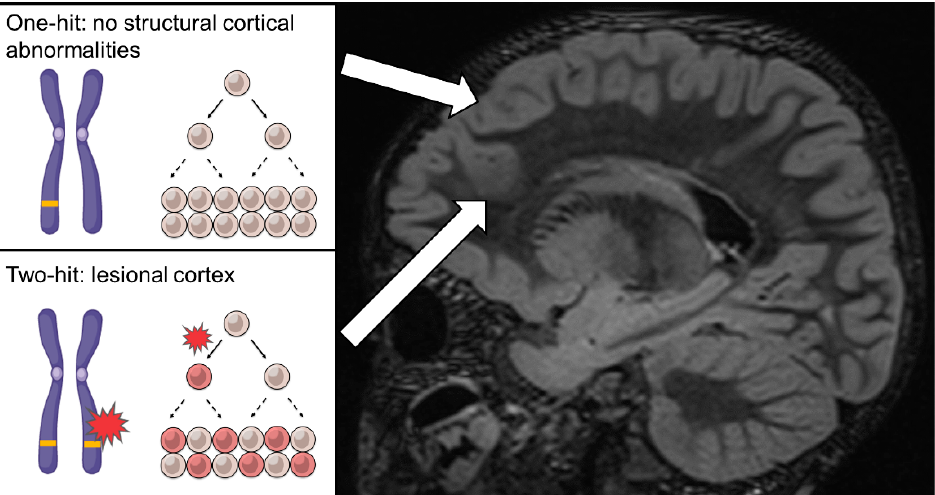
Figure 2. Illustration of two-hit mechanism in cortical dysplasia. In the unaffected cortex, a heterozygous germline DEPDC5 variant is present in all cells but does not cause “visible” lesion at MRI. In the lesional cortex, it is hypothesised that a postzygotic somatic DEPDC5 variant (or variant in another mTOR pathway genes) occurred in a subset of cells, leading to localised brain lesion.